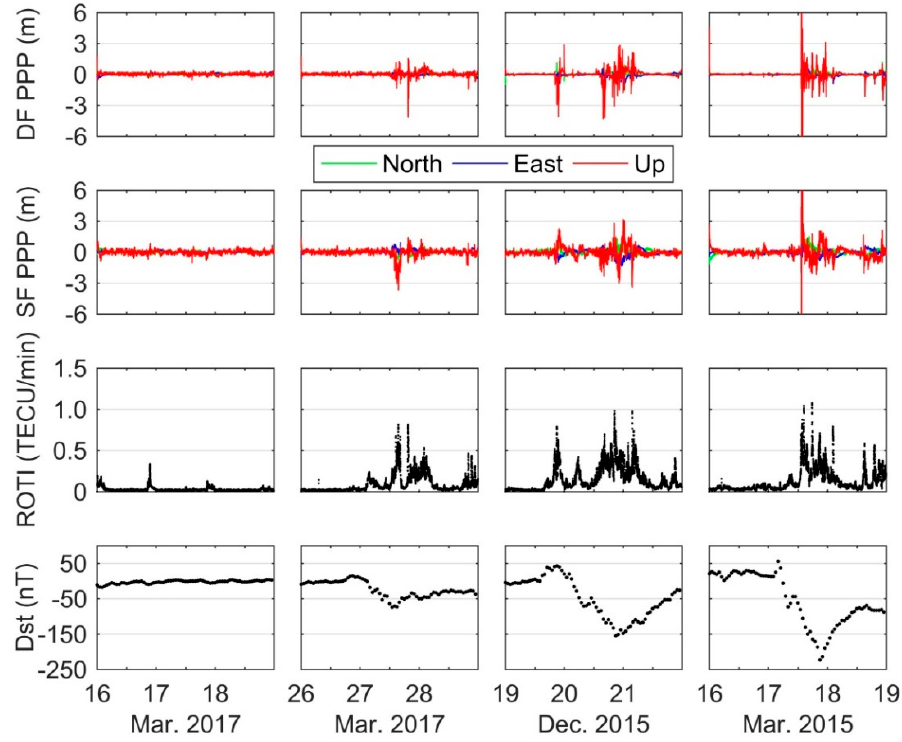
Figure 5. Time series of positioning errors of DF and SF PPP, ROTI, and Dst index for the KIRU station during the quiet, moderate, intense, and super storms period